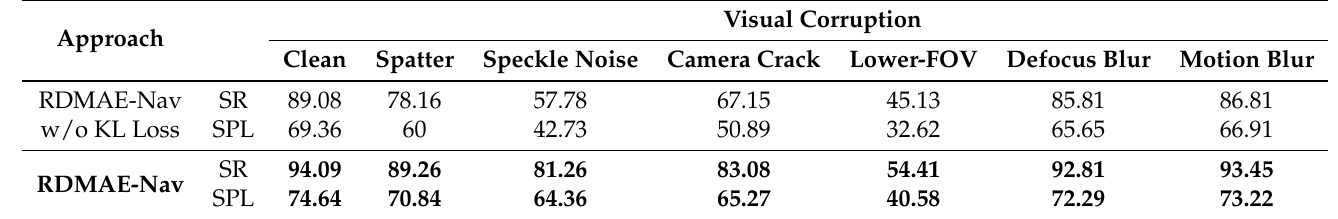
Figure 10. Histogram of contributions of KL Loss on the navigation performance of RDMAE-Nav. Table 3. Detail of contributions of KL Loss on the navigation performance of RDMAE-Nav.